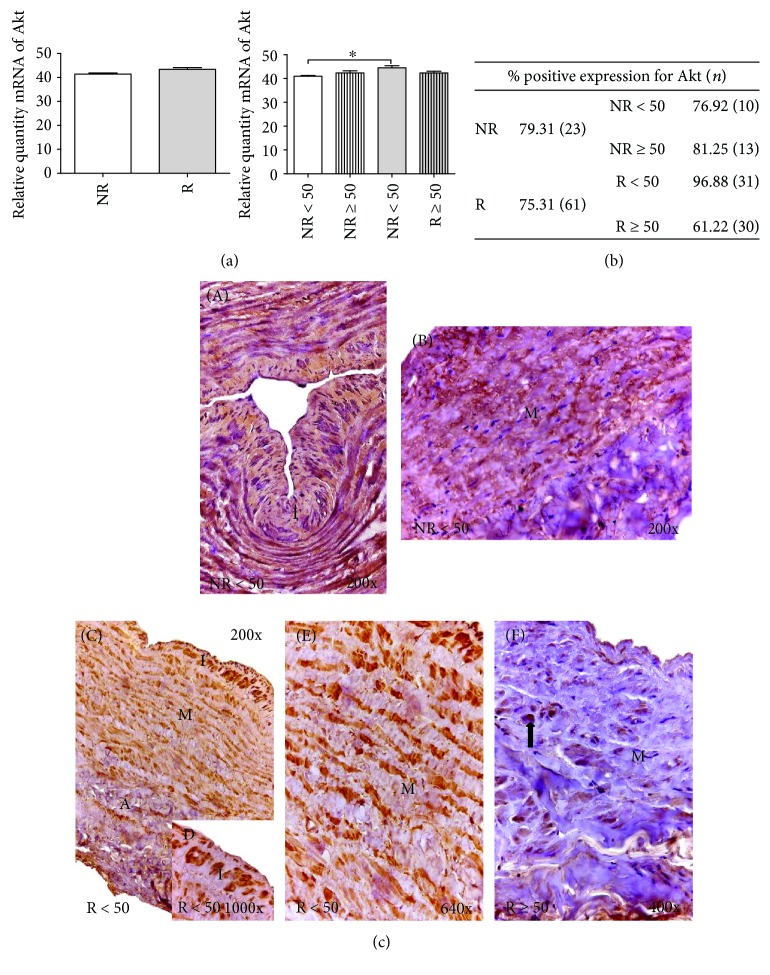
(a) Significant levels of mRNA for Akt quantified by RT-qPCR. In R < 50 patients, results were normalized to that of the reference gene GAPDH and are provided in arbitrary units. NR = no reflux; R = reflux. ∗p < 0.05. (b) Distribution of the percentage of patients with positive protein expression for Akt in NR and R patients and by age; n = number of patients. (c) A–C: Histological images for Akt protein expression in the different tunicae of venous wall in NR < 50 (200x), NR ≥ 50 (200x), and R < 50 patients (200x). D-E: Detail of expression for Akt at greater magnification in R < 50 for tunica intima (640x) and tunica media (640x). F: R ≥ 50 patients show a heterogeneously Akt protein expression as small accumulations (arrow) in the tunica media (400x). A = tunica adventitia; M = tunica media; I = tunica intima. The brown coloration indicates the specific precipitate that correlates with the expression of the said protein.